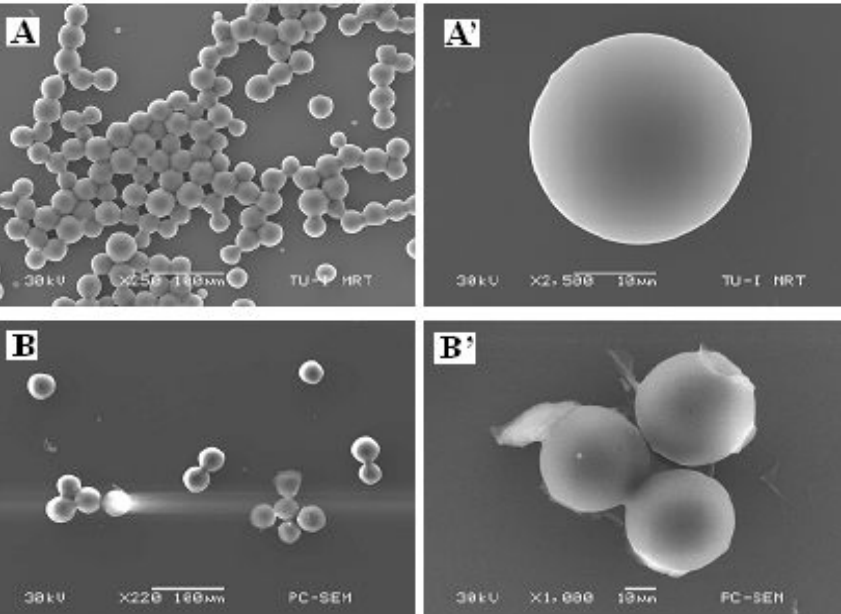
Figure 30. Micrographs of nano-Au/Poly(TPGDA) microparticles (A,A’) and nano-ZnO/Poly(TPGDA) microparticles (B,B’) at two different magnifications